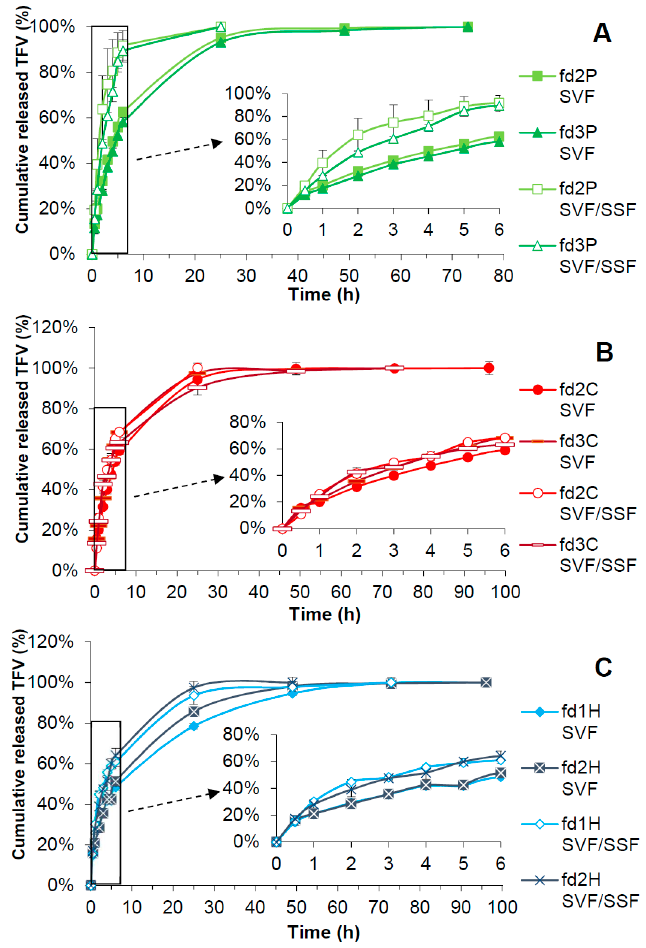
Figure 6. Cumulative drug release profiles obtained from tests in SVF and in SVF / SSF mixture for freeze-dried systems containing pectin ( A ), chitosan ( B ), and HPMC ( C ). In each graph the first 6 h of test are amplified at the bottom right.